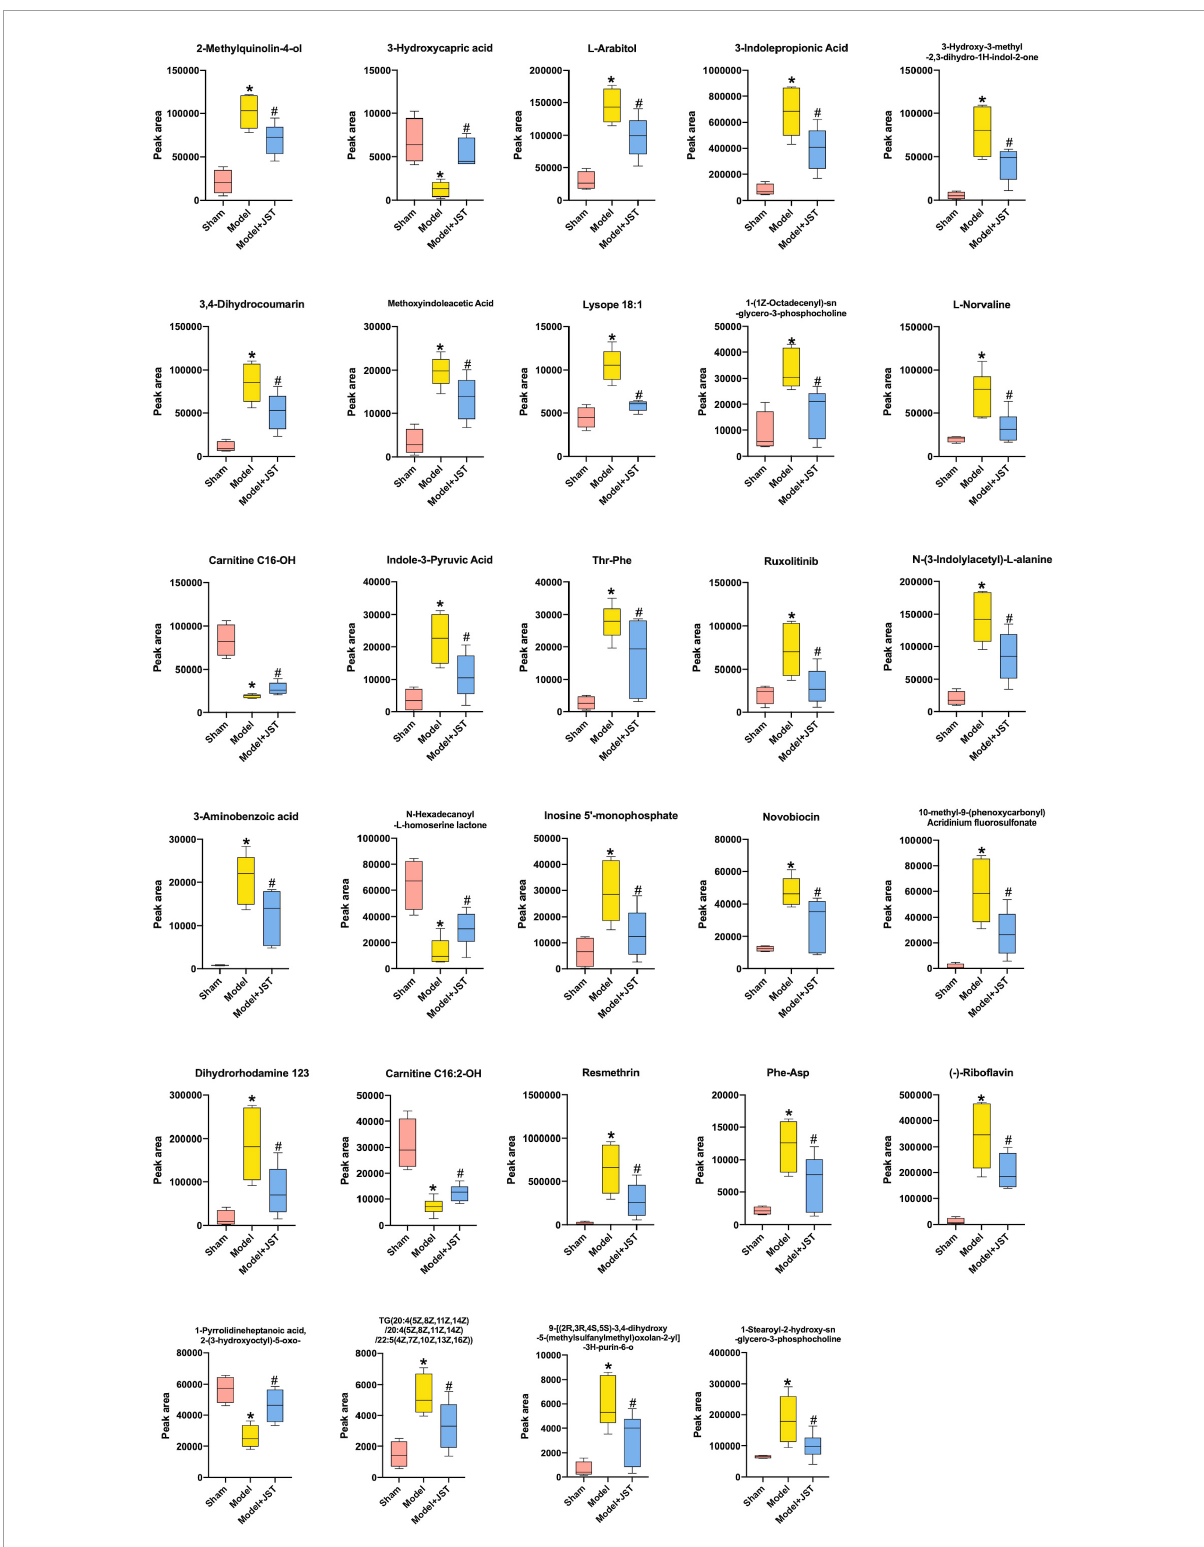
FIGURE6 Identified 29 metabolites that were restored by JST treatment in heart failure rats. All data were expressed as mean ± SD ( n = 4–6). * P < 0.05, vs. Sham group; # P < 0.05, vs. Model